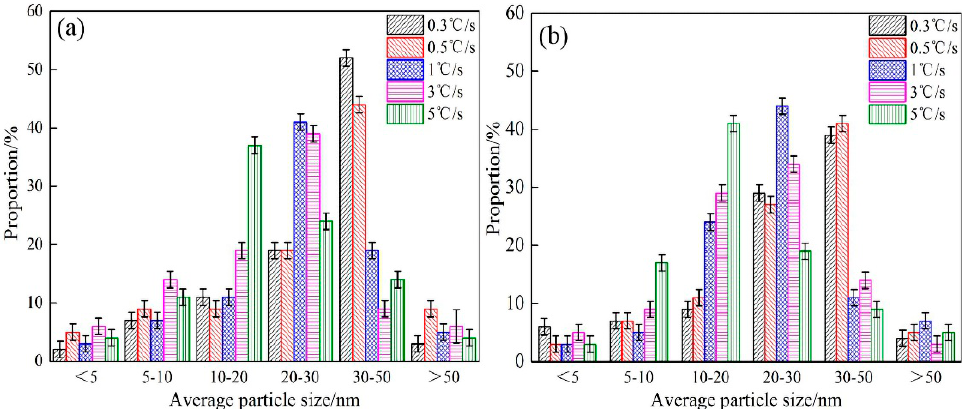
Figure 12. Size distribution of precipitates in ( a ) steel 1# and ( b ) steel 2# at different cooling rates. Combining the above precipitation behavior analysis with the principle of the Nb element, when the cooling rate increases, the decrease of temperature is accelerated, and the atomic diffusion rate decreases sharply with the decrease of temperature, so the growth rate of precipitated phase nuclei decreases. According to the thermodynamic calculation of (Nb, Ti, V)C precipitates in Figure 4, steel 2# mainly precipitates Nb − rich or Nb and V − rich carbides. Nb precipitates preferentially at high temperatures, and the precipitation rate is faster. Therefore, the particle size of Nb/Ti/V precipitates can be ef- fectively reduced by appropriately increasing the cooling rate and the content of Nb el- ements in the steel.